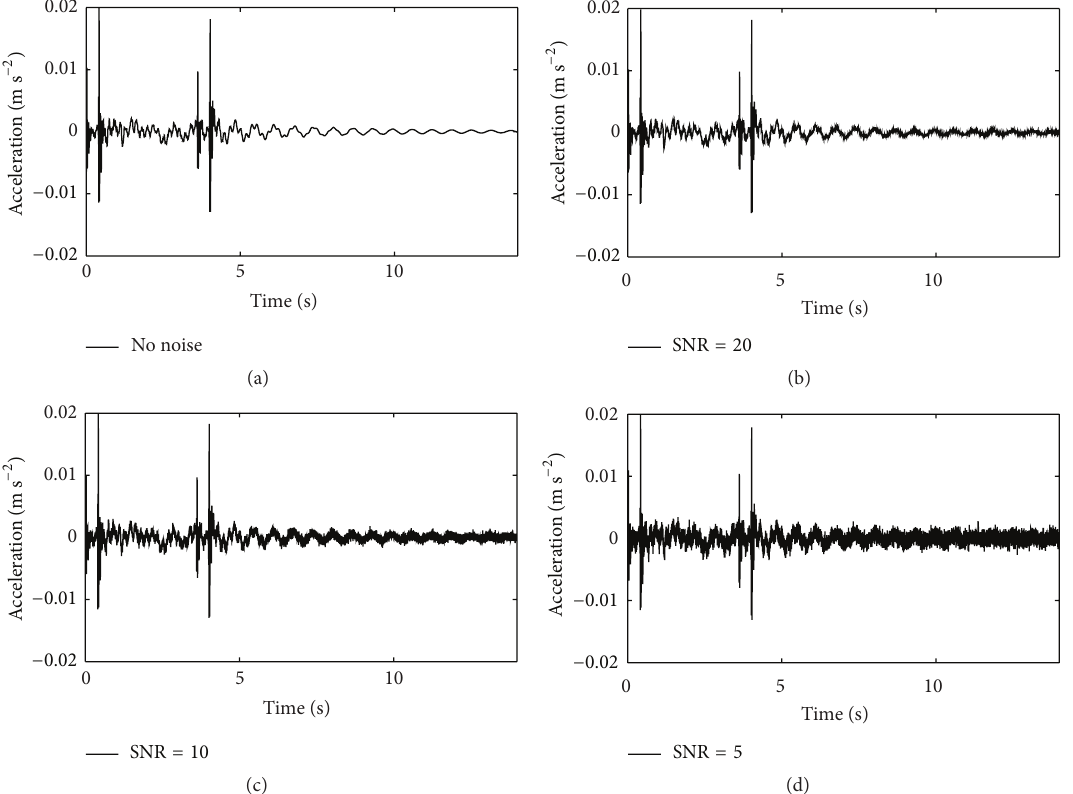
Figure 11: Effect of noise on lateral pier acceleration response. (a) Noise-free signal; (b) signal with SNR = 20; (c) signal with SNR = 10; (d) signal with SNR = 5.